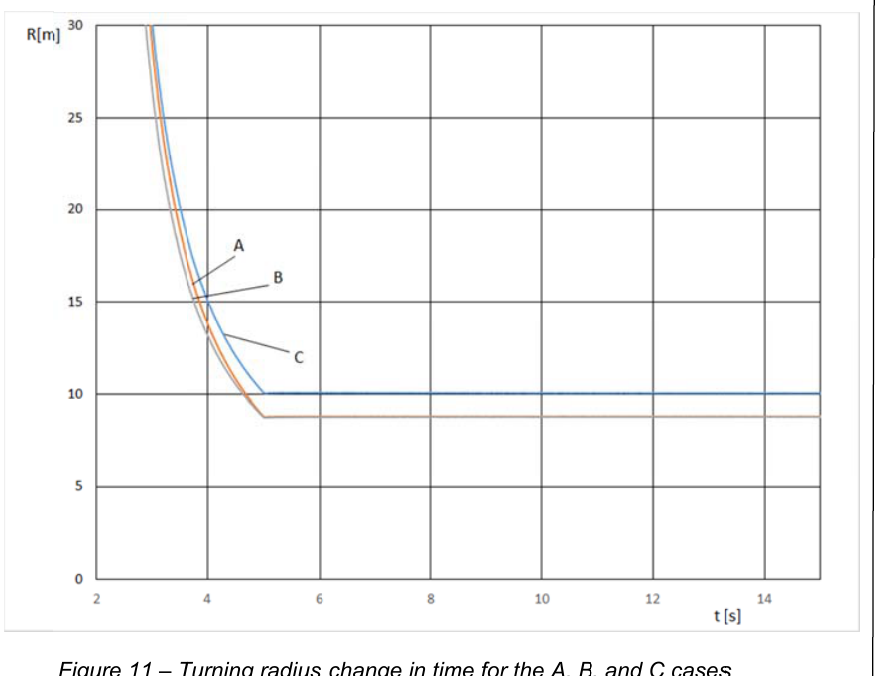
Figure 11 – T Рис . 11 –